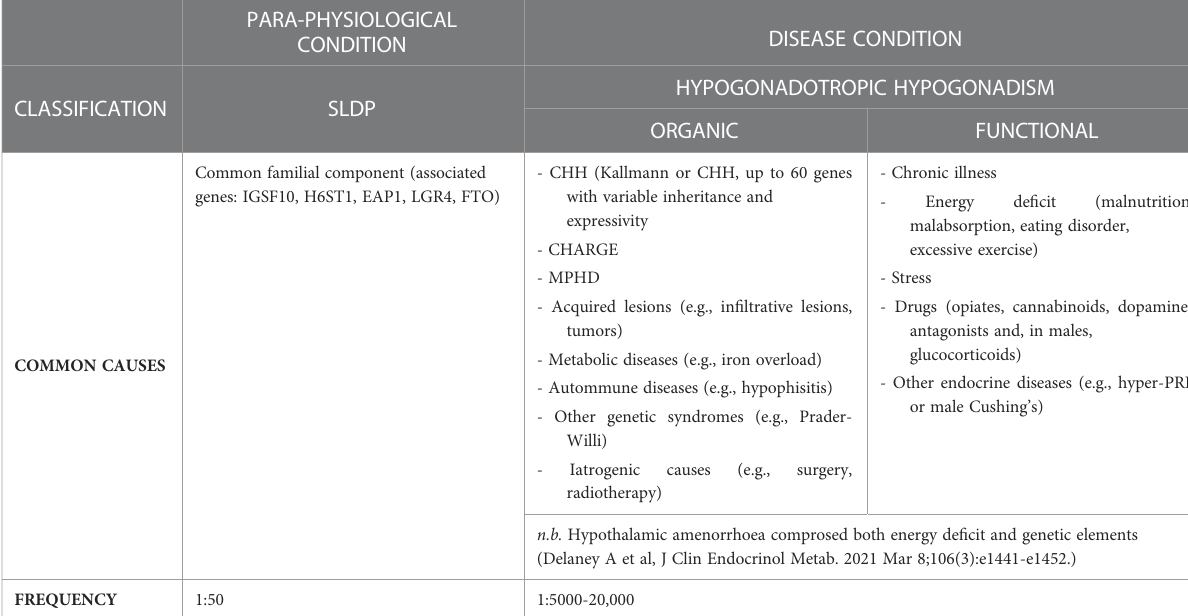
TABLE 1 List of conditions associated with CHH or